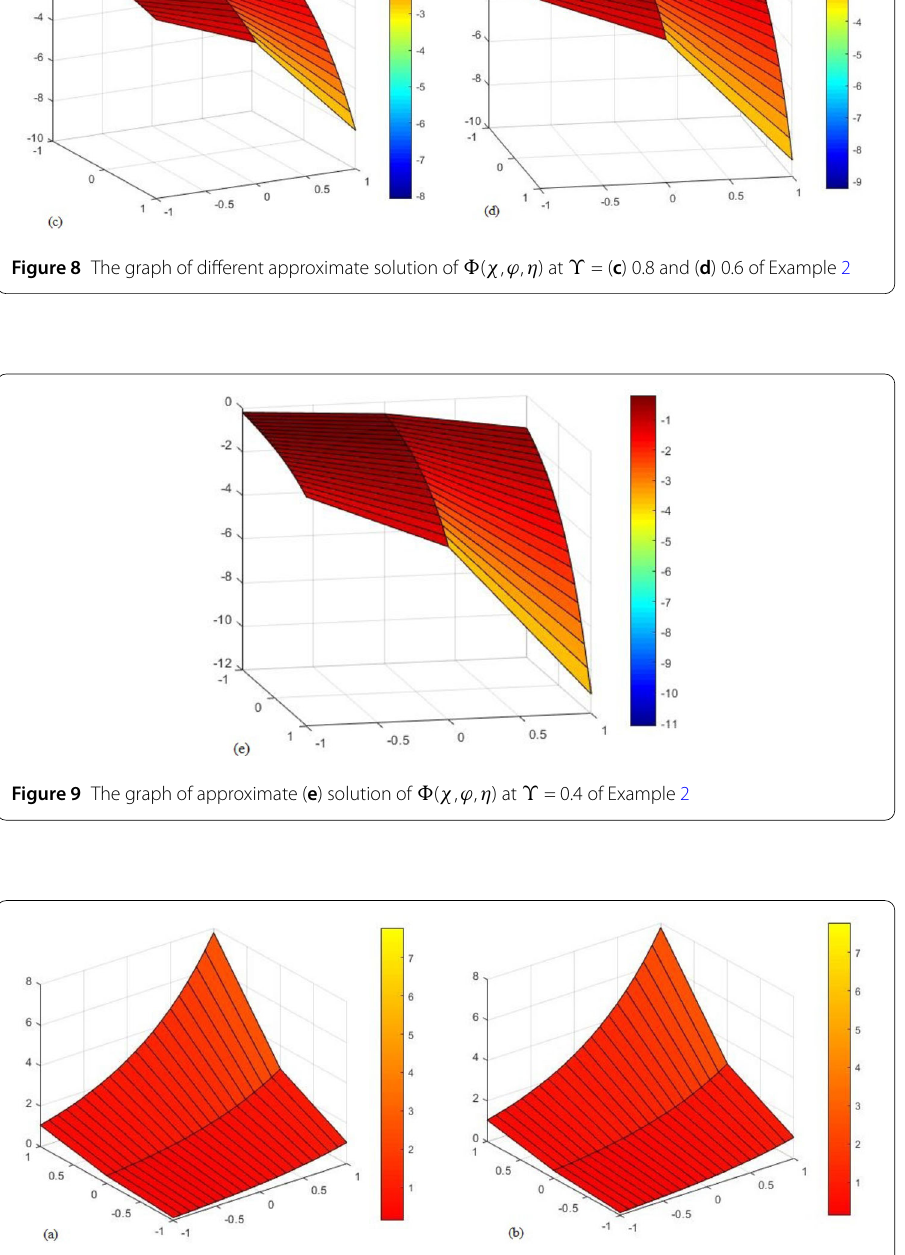
ϒ = 0.8,0.6, and 0.4 for (cid:11) . In Fig. 10, we show the exact and analytical solution of (cid:13) at ϒ = 1. In Figs. 11 and 12 for different values of ϒ = 0.8,0.6, and 0.4 for (cid:13) . The fractional results are investigated to be convergent to an integer-order result of each